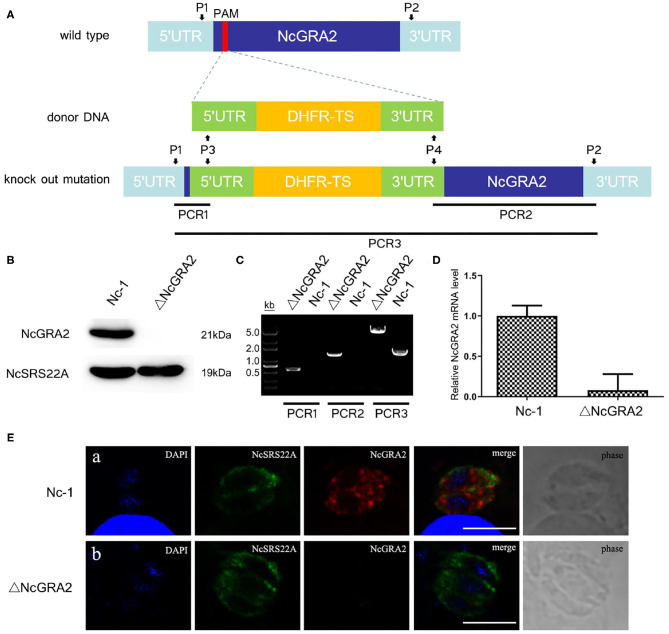
Construction of the ΔNcGRA2 strain. (A) Schematic diagram of NcGRA2 gene disruption strain construction and primer design strategies for PCR assessment of the ΔNcGRA2 strain. (B) Western blotting assessment of NcGRA2 gene disruption by measuring the protein expression levels of NcGRA2 in the Nc-1 strain and ΔNcGRA2 strain. NcSRS22A was used as control. (C) PCR assessment of NcGRA2 gene disruption by measuring the genome levels in the Nc-1 strain and ΔNcGRA2 strain. (D) qPCR assessment of NcGRA2 gene disruption by measuring the transcription levels in the Nc-1 strain and ΔNcGRA2 strain. (E) Immunofluorescence assessment of NcGRA2 gene disruption by localization analysis of the NcGRA2 protein in the Nc-1 strain and ΔNcGRA2 strain. NcSRS22A was used as control. Bar = 5 μm.